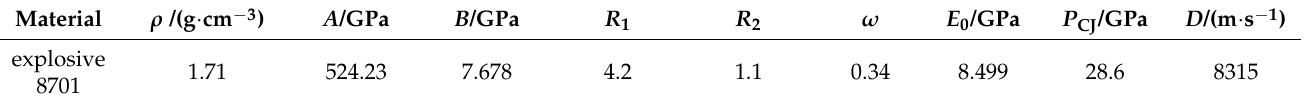
Table 3. Parameters of explosive 8701 [28].